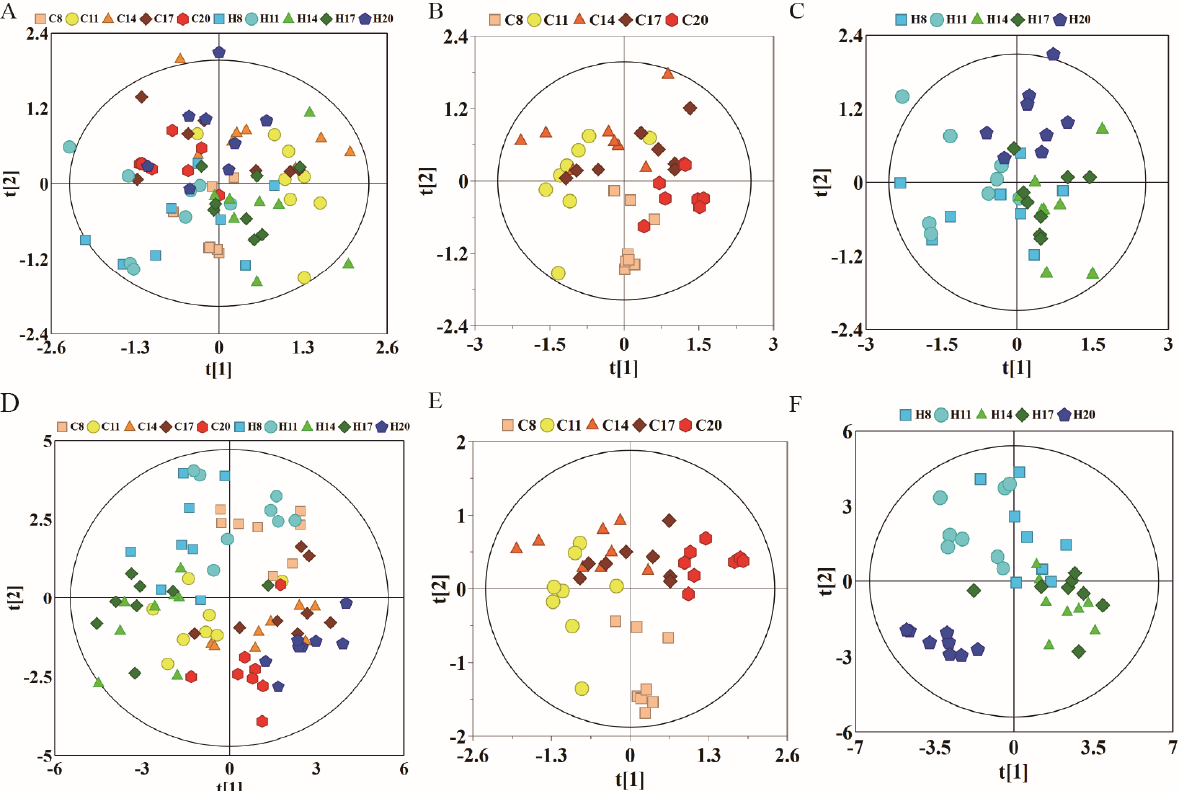
Figure 5. PCA and corresponding PLS-DA scores plots derived from 1 H NMR spectra of urine samples obtained from different groups at different gestation period. ( A ) PCA score plots of control group and hypoxia group; ( B ) PCA score plots of control group; ( C ) PCA score plots of hypoxia group. ( D – F ) corresponding PLS-DA score plots of ( A – C ). (C: control group; H: hypoxia